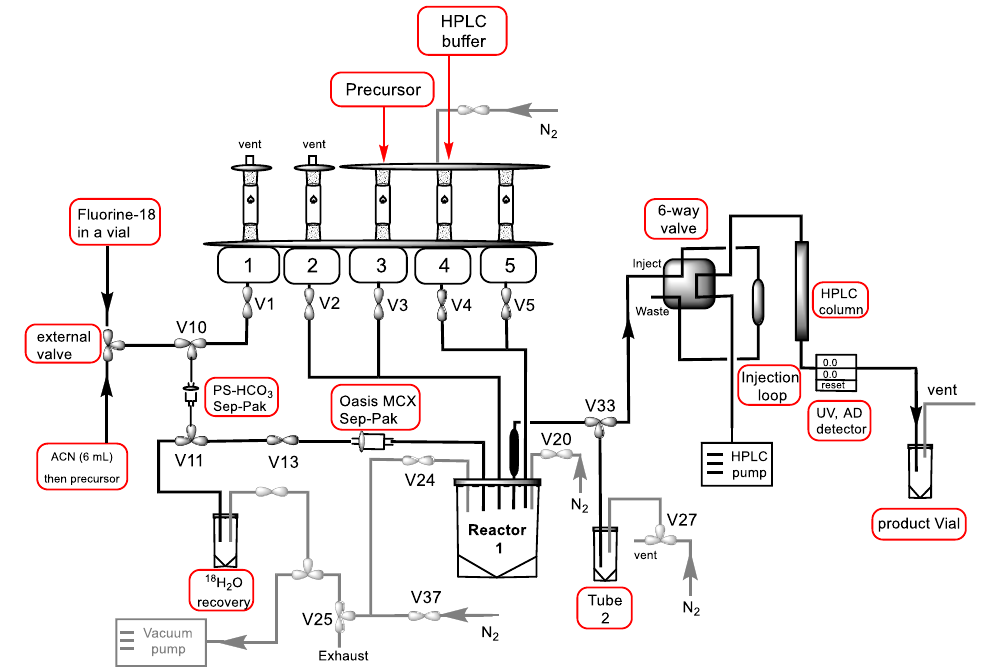
Figure 1. Schematic diagram of the automated synthesis on GE FX-N Pro Module.